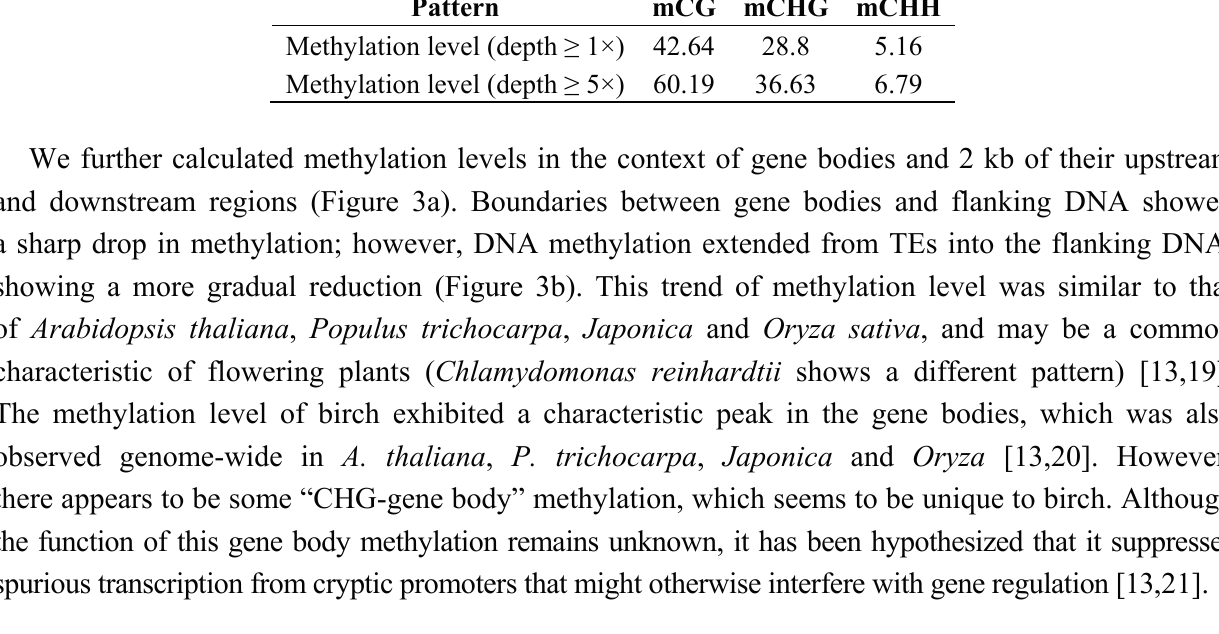
Figure 3. Methylation level of transposable elements (TEs), gene body and its upstream and downstream sequences. ( a ) Methylation levels of the gene body and its upstream and downstream sequences. Two-kilobase regions upstream and downstream of each gene were divided into 50 bp intervals and analyzed. Each gene body was divided into 40 intervals for analysis; ( b ) Methylation level of TEs. TEs and 0.5 kb flanking sequences regions on both sides were analyzed. Each TE was divided into 20